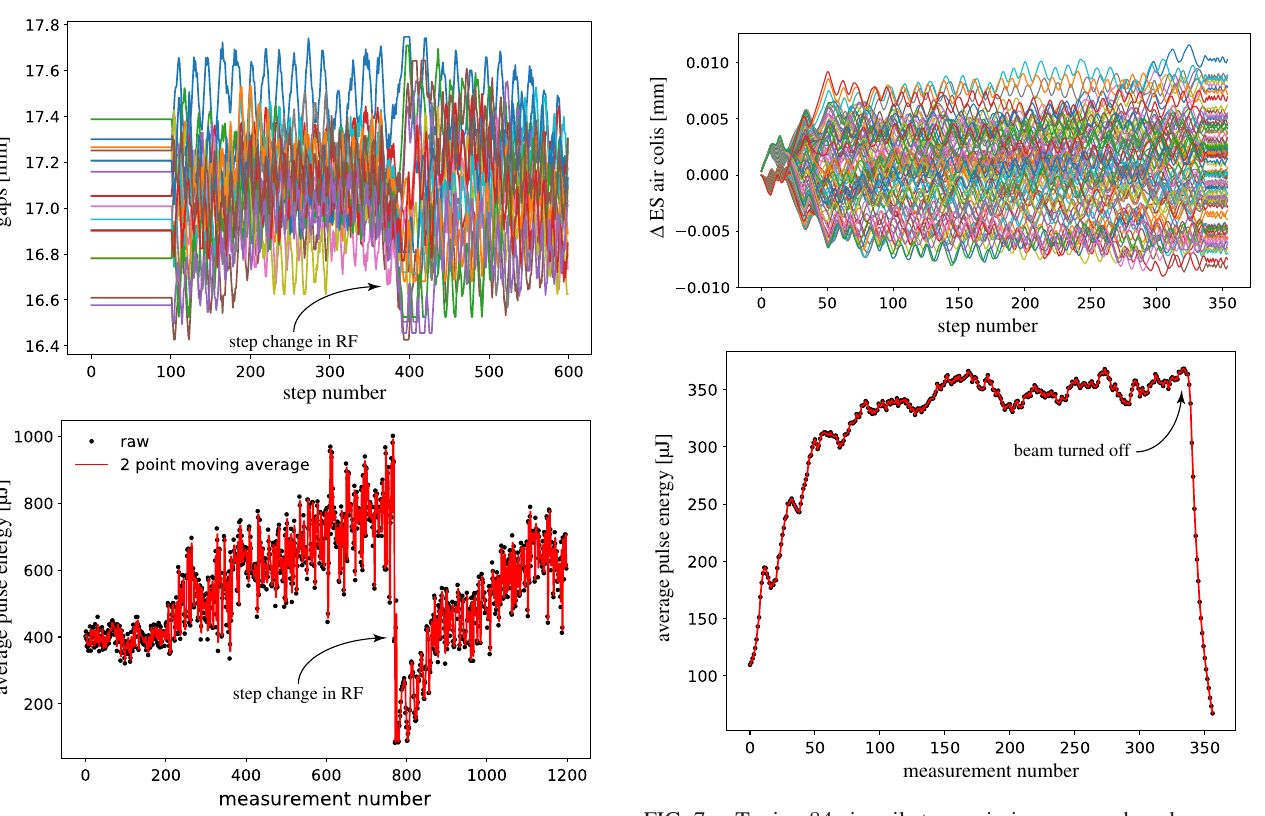
FIG. 6. During tuning, a large step change in the rf system causes a sudden drop in the average bunch energy. The adaptive algorithm is seen to automatically begin readjusting the gaps to compensate for this.